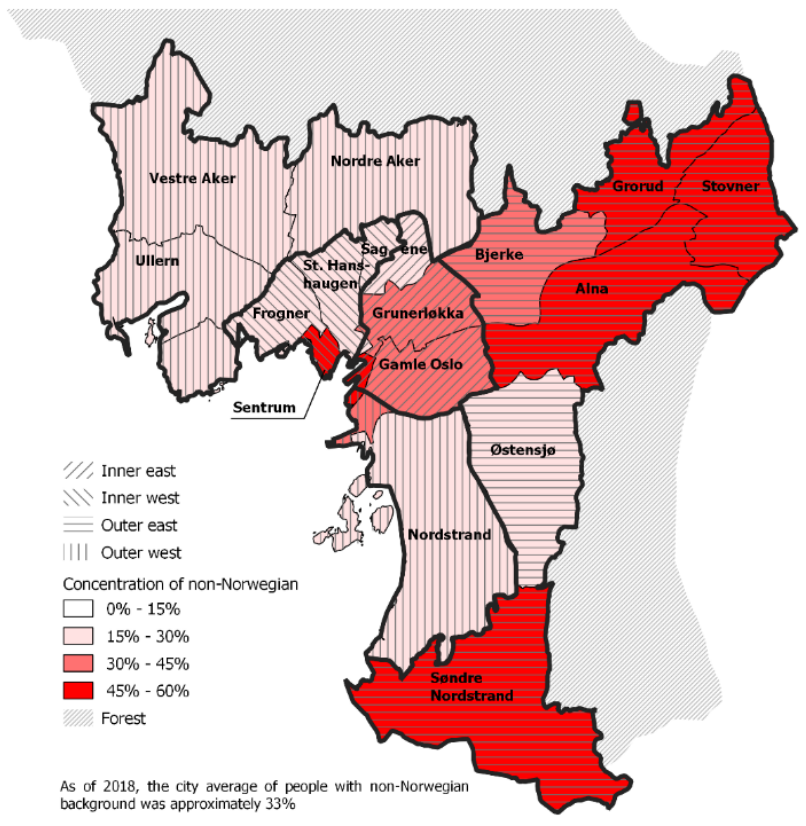
Figure 1. Residential ethnic composition in 2018. Source: Authors’ elaboration on data provided by Oslo Statistikkbanken